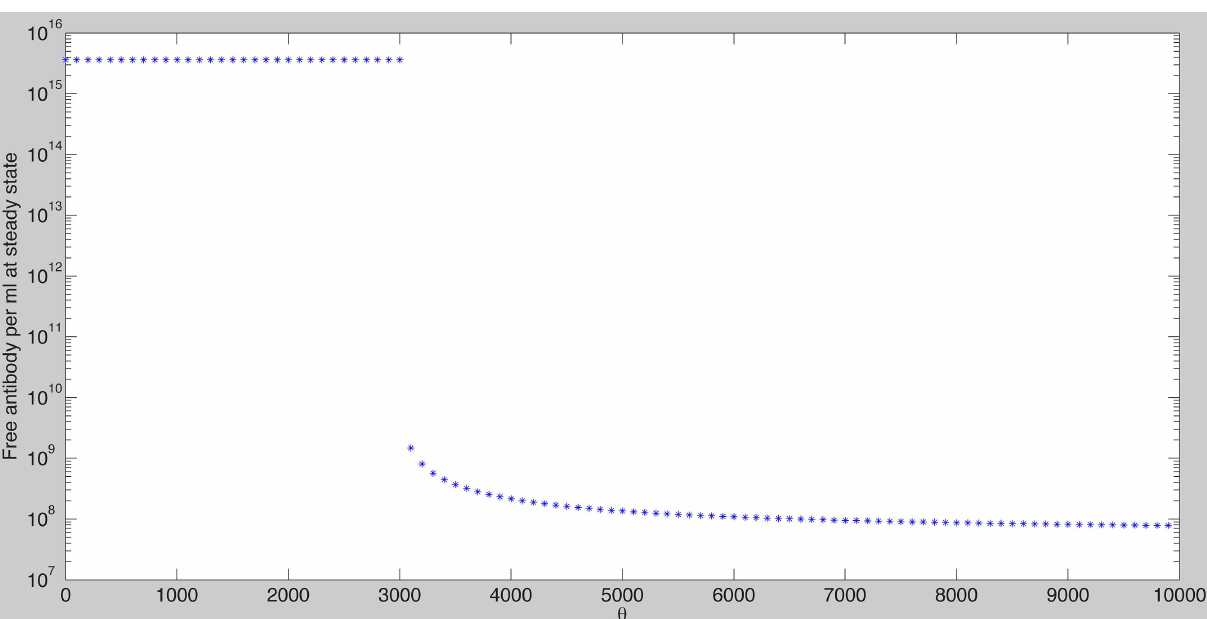
Figure 3. Free antibody at steady state as given by model (7) as a function of h . The other parameters are as Tables 1 and 2 (median values). Note that for h v 3000 , the antibody reaches its carrying capacity C . For h w 3000 the infection is not cleared and the maximum antibody value is less than the carrying capacity C .